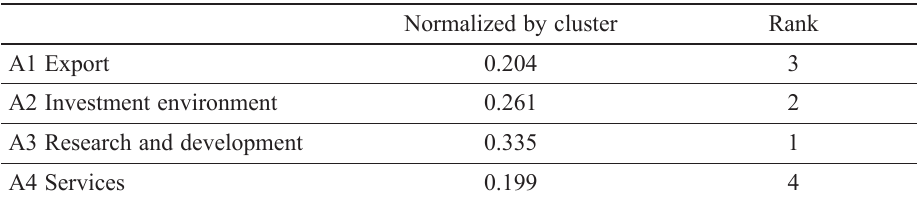
Table 5. Prioritization of the alternatives under benefit network Normalized by cluster